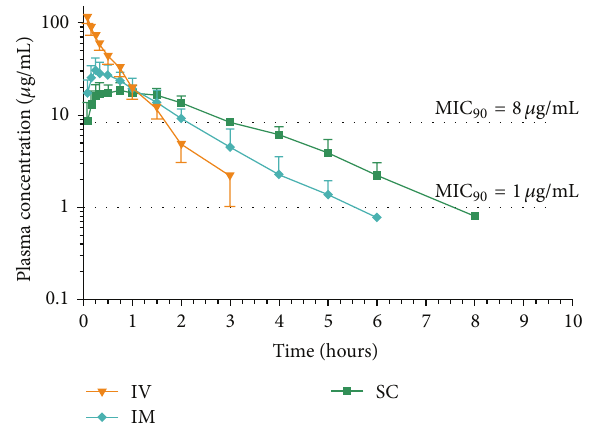
Figure 1: Mean ± SD of plasma cephalexin concentrations follow- ing immediate release formulation administration (10mg/kg) by the intravenous (IV), intramuscular (IM), and subcutaneous (SC) routes to 6 llamas.